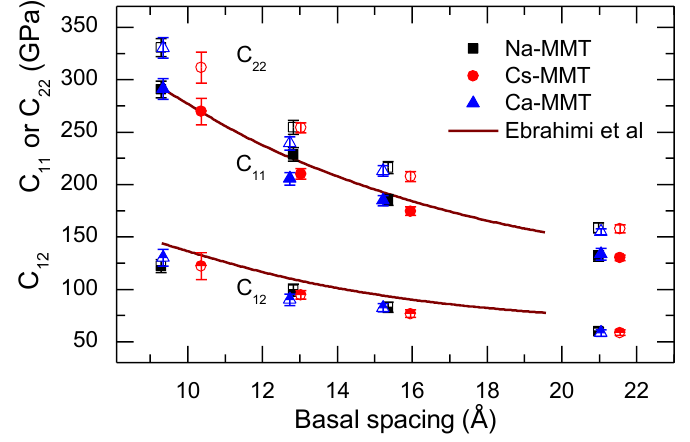
Figure 7. The C 11 , C 22, and C 12 elastic constants as a function of basal layer spacing. For the shear of clay under high pressure, the most concerned is the shear resistance of limited interlayer water molecules in the hydrated MMT system, i.e., the in-plane shear stiffness tensor components C 44 and C 55 . Their variations with basal spacing are shown in Figure 8; C 44 and C 55 fluctuate with the increase of water content which is like the variation of C 33 . Therefore, the mechanism of shear strength of interlayer water is closely related to the formation of H-bonds and atom-free volume. The shear strength between dry MMT lamellae is much larger than that of hydrated MMT lamellae, that is to say, the addition of water plays a lubricating role in interlayer friction, which makes C 44 and C 55 decrease sharply. However, these limited interlayer water molecules do not completely show the zero shear strength characteristics of free water. As water content increases, the in-plane shear strength increases to a local maximum when the system approaches the thermodynamic stable state and minimum atom free volume occurs. In the range of simulated water content, C 44 and C 55 eventually tend to be constant. Furthermore, the results in Figure 8 shows that the components C 44 and C 55 are in good agreement with those obtained by [29], and the in-plane shear strength between different MMT systems is close except for the dry MMT system. Meanwhile, the simulated results also fall well into the UPV measurement range of [17] ( C 44 = 2.9~8.9 GPa).